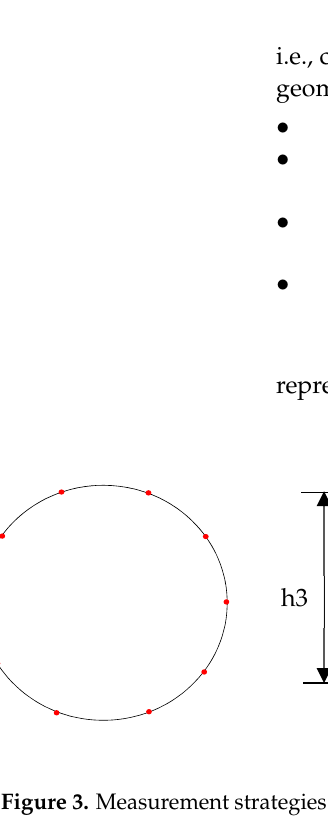
Figure 3. Measurement strategies for different features. The red dots represent the locations where the CMM probe recorded the measurement data.